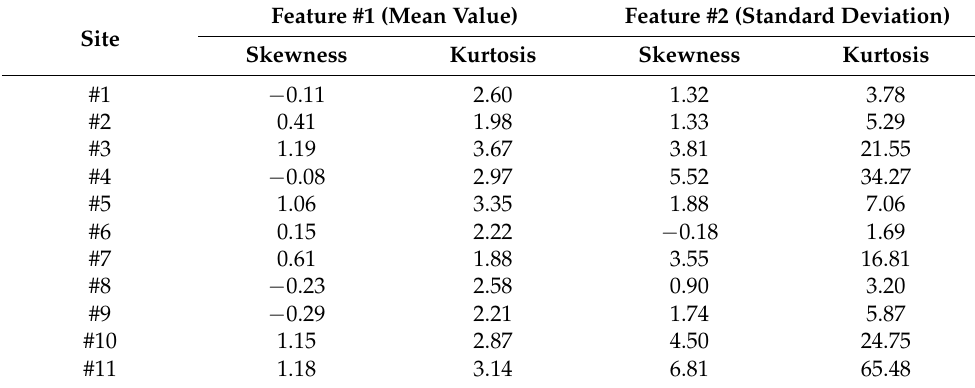
Table 2. Skewness and kurtosis of the field